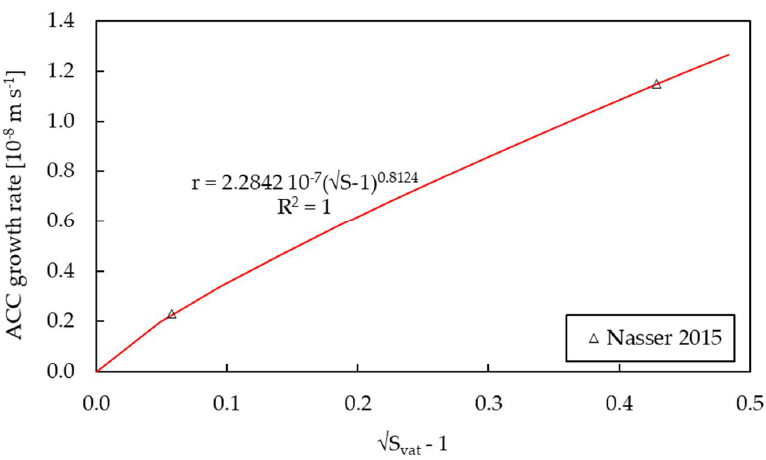
Figure 4. Growth data calculated from Nasser. Because there are only two data points, the calculated parameters should be used carefully.